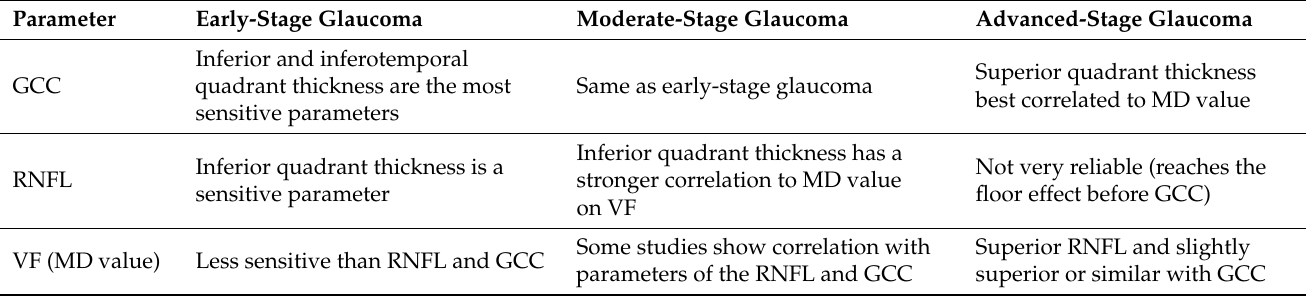
Table 1. Summary of the GCC, RNFL and VF parameters in different glaucoma